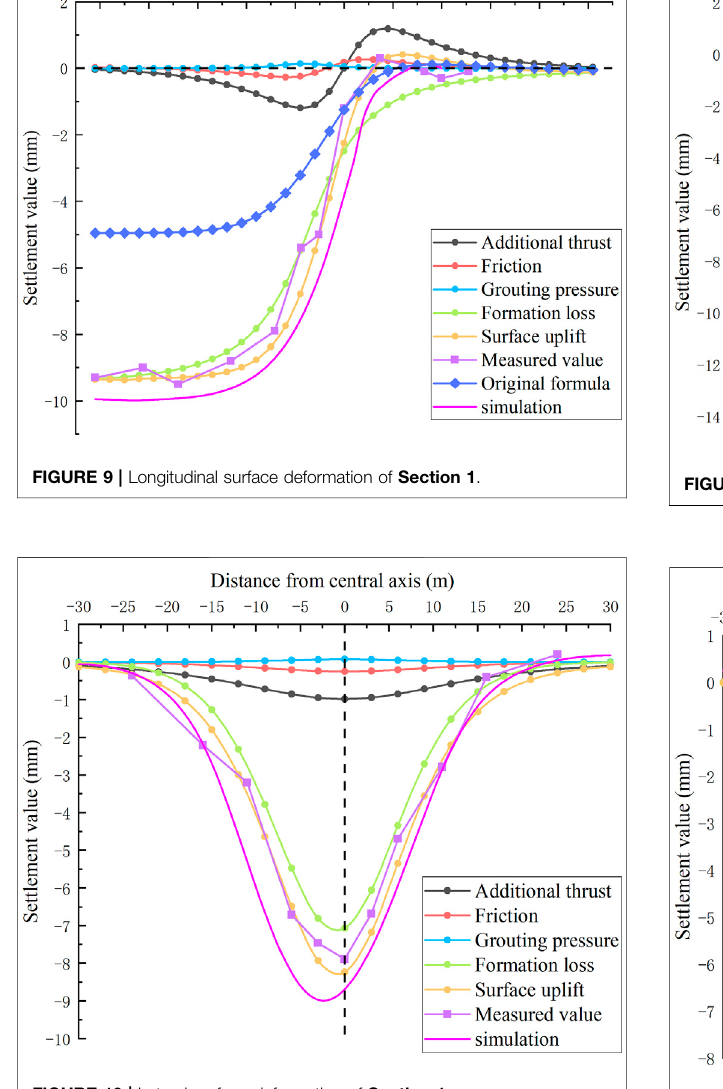
FIGURE 12 | Lateral surface deformation of Section 2